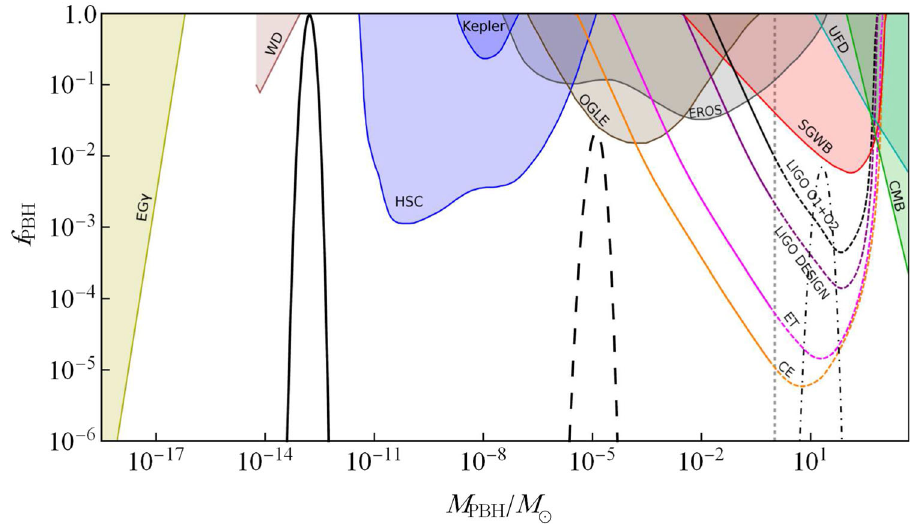
Fig. 4 The fractional abundance of PBHs as a function of PBH mass for Case 1 (solid black line), Case 2 (dashed black line), and Case 3 (dash-dotted black line). The black, purple, magenta, and orange curves indicate the results of targeted search from aLIGO O1 and O2, aLIGO design, ET [166], and CE [175], respectively [199]. The dashed lines illustrate the detectable limits of f PBH from these detectors. The gray vertical line shows that the constraints from the targeted search are only valid for the sub-solar mass PBHs [199]. The red curve is the updated upper bound of f PBH constrained by the non-detection of SGWB from both aLIGO O1 and O2 searches. The other shaded